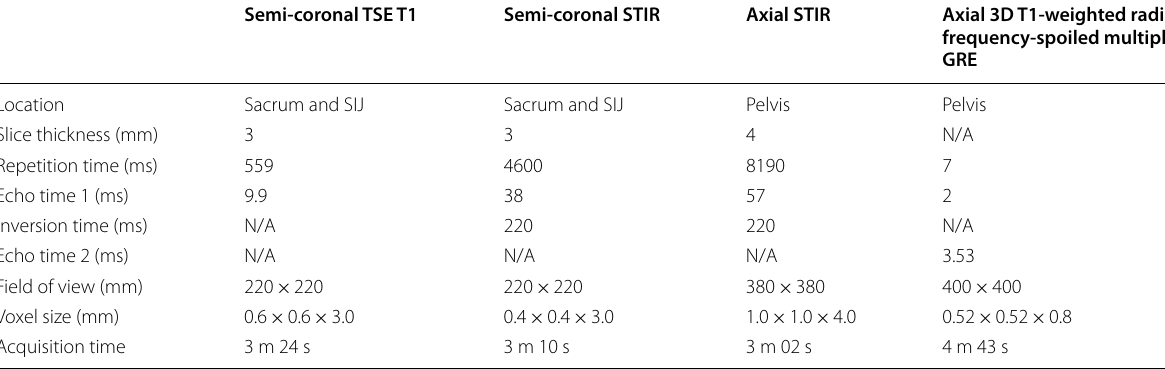
MRI Magnetic resonance imaging; TSE = mm millimeter; N/A =